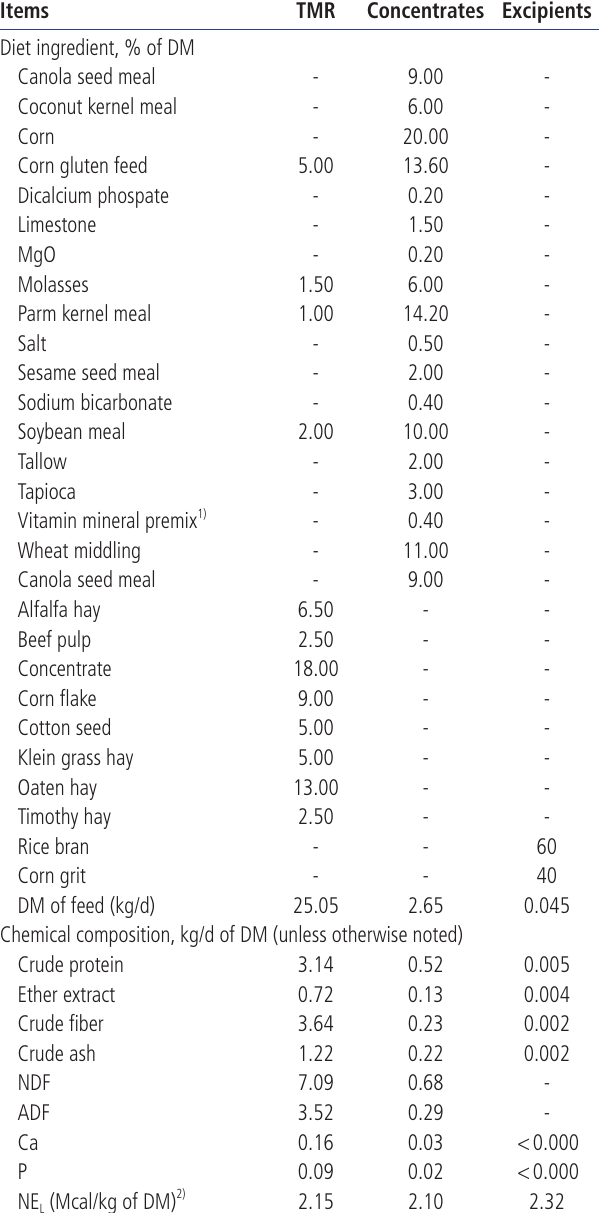
Table 1. Ingredient and chemical composition of the experimental diets used in Experiment